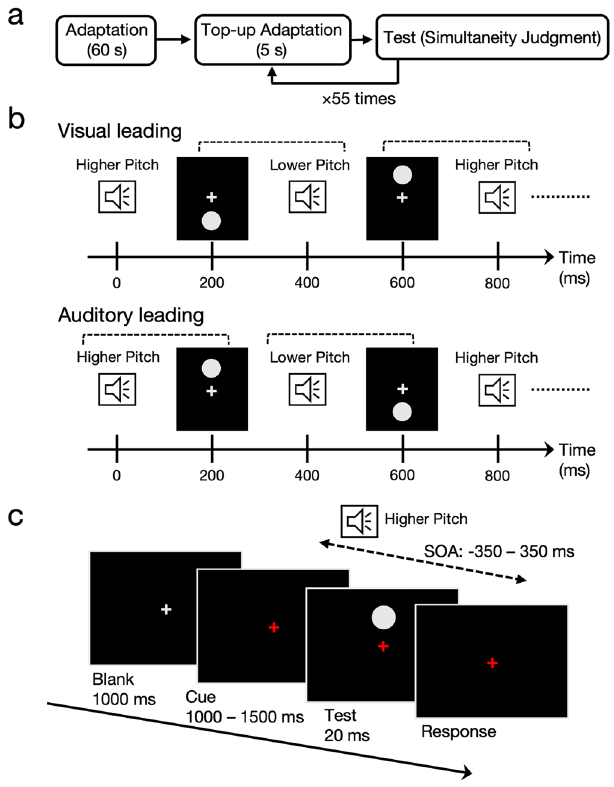
Figure 1. Design and procedure of Experiment 1. ( a ) Timeline of the experimental procedure in each block. ( b ) Schematic illustration of the two adaptation conditions. Audio and visual stimuli were presented alternatively with grouping implied by the congruency with cross-modal correspondence between auditory pitch and visual elevation (shown as dotted lines). ( c ) The procedure of a single test trial (a simultaneity judgment